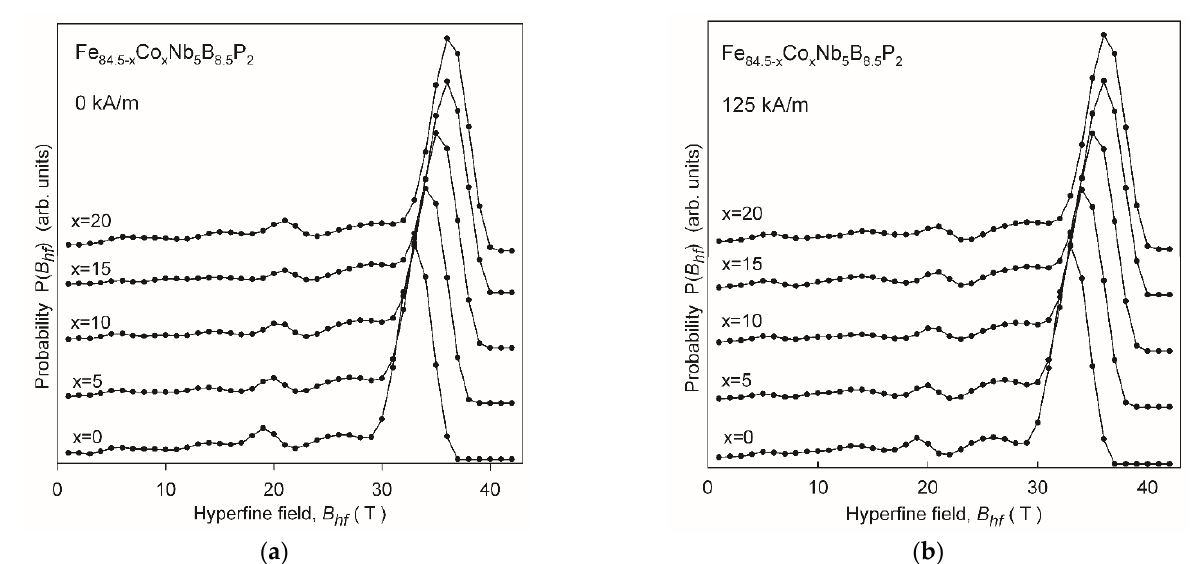
Figure 14. ( a ) Distributions of hyperfine fields determined from the Mössbauer spectra in Figure 13 (left column); ( b ) Distributions of hyperfine fields determined from the Mössbauer spectra in Figure 13 (right column).